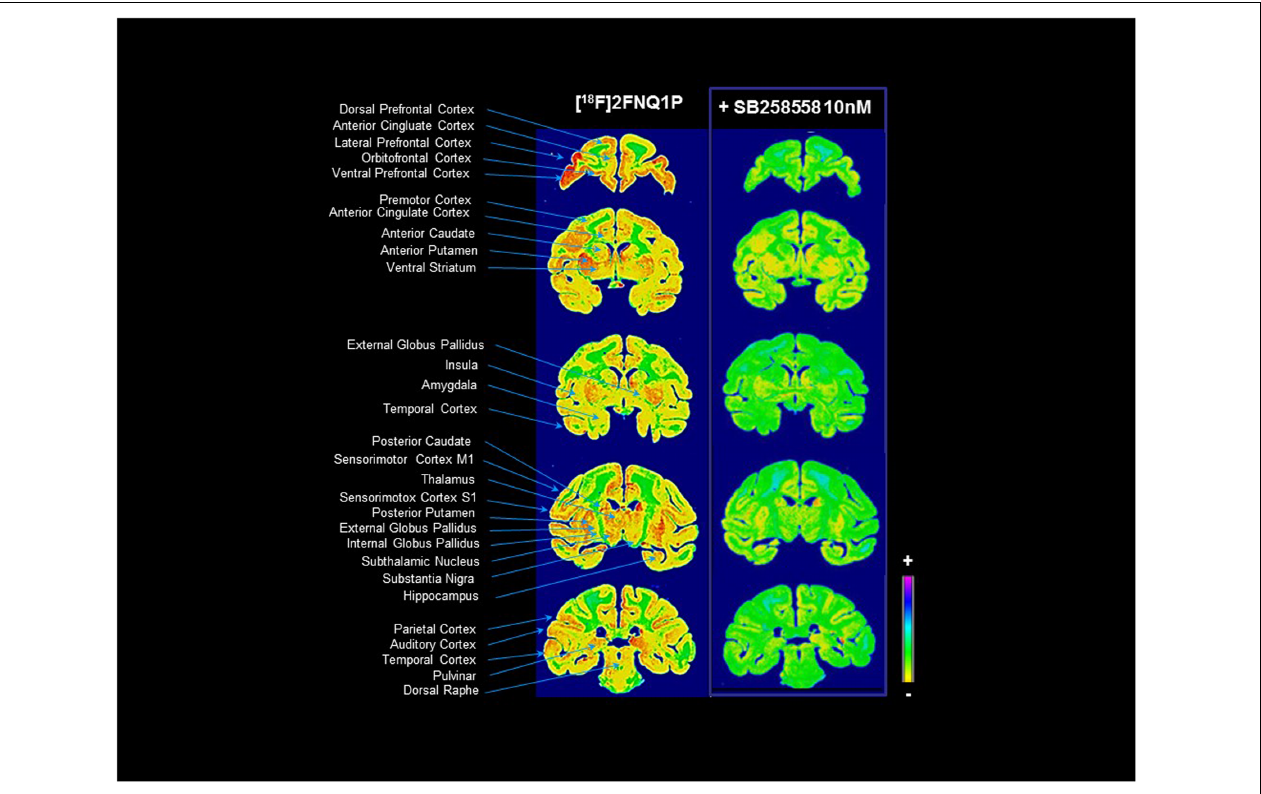
FIGURE 1 | [ 18 F]2FNQ1P BP ND in vitro distribution in macaque brain. Monkey cerebral sections were processed for in vitro autoradiography with [ 18 F]2FNQ1P under baseline condition and in presence of cold SB258585 (at 10 nM). Coronal sections were taken in the whole rostrocaudal extension of the monkey